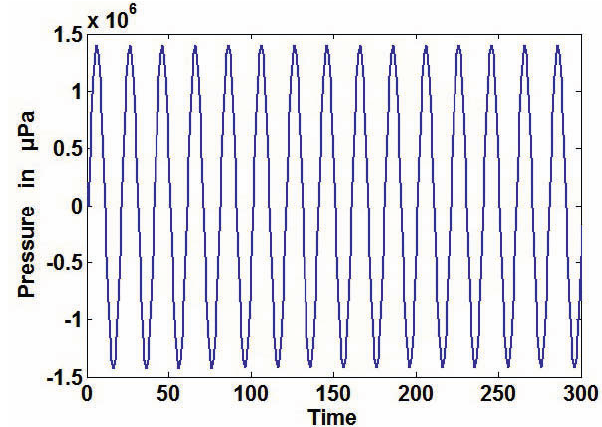
Figure 5. Input signal ( 0:0053 D 5